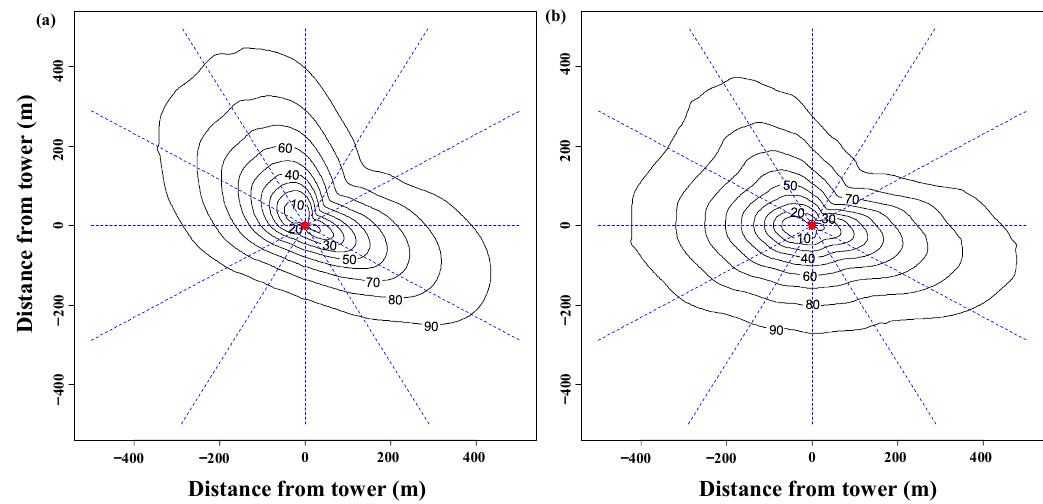
Figure 3. Flux footprint during the ( a ) growing season and ( b ) dormant season. The red circle represents the measurement tower; the black solid lines represent isopleths of accumulated percentage flux contributions to measured values.